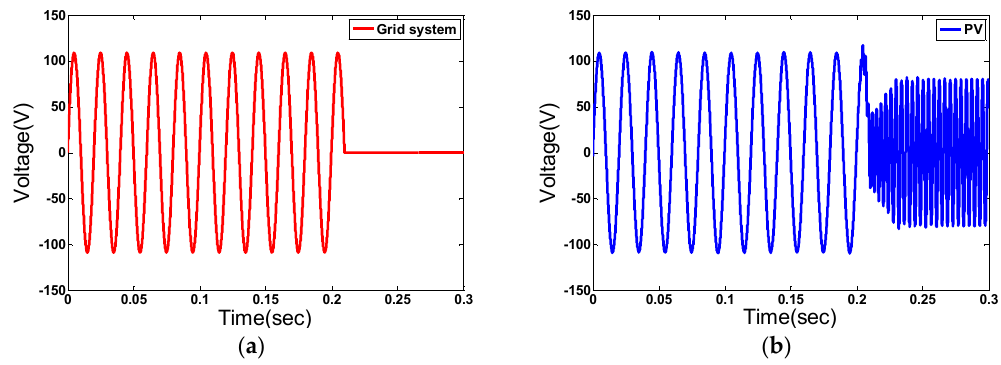
Figure 8. ( a , b ) Waveforms of generated solar power disconnected from the grid.